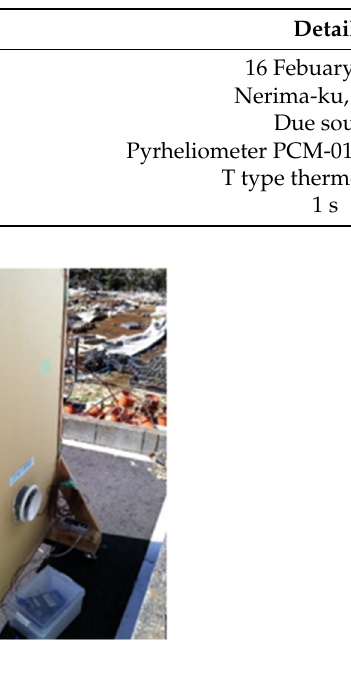
Figure 4. Correlation between measured and calculated supply air temperature. 3. Building Used for Verification 3.1. Building Overview The measurements were conducted at a two-story wooden house in Sapporo, Hok- kaido. Figure 5 shows a photograph of the building and Table 3 shows an outline of the building. The dotted lines indicate the solar air heater, which also serve as air supply vents. The city of Sapporo, where the building was constructed, is located at latitude 43° N and longitude 141° E, and the average outside temperature in the coldest month is − 4.6 °C. It is an area with heavy snowfall, with a maximum snow depth of 80 cm and a cumu- lative snowfall of more than 550 cm. Two solar air heaters are installed on the south exterior wall, which also serves as the fresh outside air intake for passive ventilation. The floor area is about 125 m 2 , and the family consists of four people. The heating is done by running hot water through a radia- tor installed underfloor space.